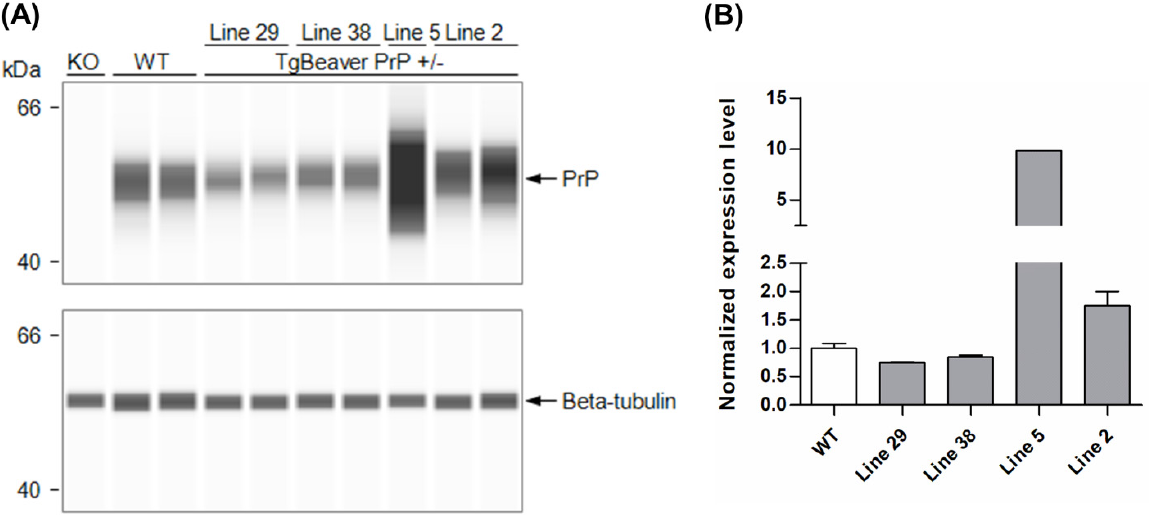
Figure 1. Generation and evaluation of transgenic mice expressing beaver Prnp . ( A ) Capillary Western images and ( B ) chart showing PrP C expression levels (mean values ± S.D.) in brain homogenates of hemizygous TgBeaver PrP mice derived from several different transgenic founders. PrP C signals were corrected for loading error based on beta-tubulin signals before normalization against the WT mean value. The TgBeaver mice were homozygous null for the endogenous mouse Prnp locus. The monoclonal antibody Sha31 was used to detect PrP C . KO, knockout; WT wild-type FVB mice. Cohorts of tgBeaver mice (line 2) were challenged with five strains of CWD, four isolates of rodent-adapted prions and one strain of CJD to test the capacity of beaver PrP C to sustain prion replication and induce prion disease (Table 1, Figures S3 and S4). Fulmi-